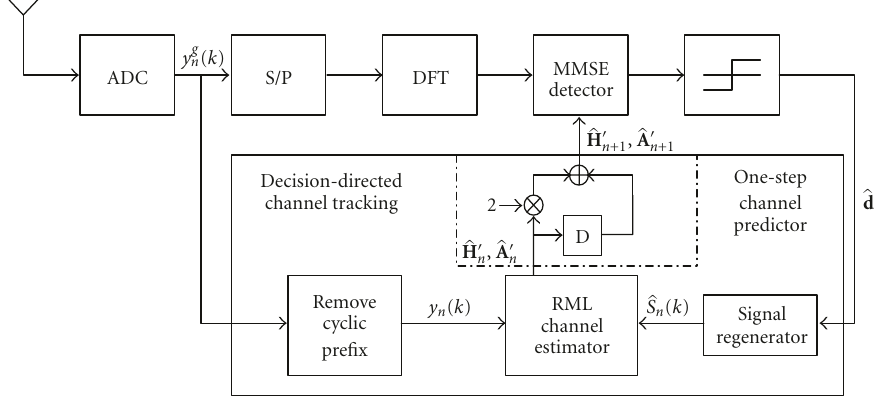
Figure 2: Block diagram of the decision-directed channel-tracking algorithm.